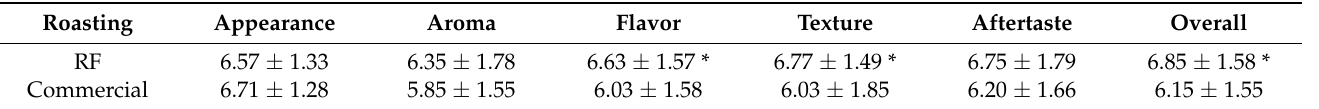
Table 2. Consumer 9-point-scale hedonic sensory evaluation of RF-roasted and commercial roasted